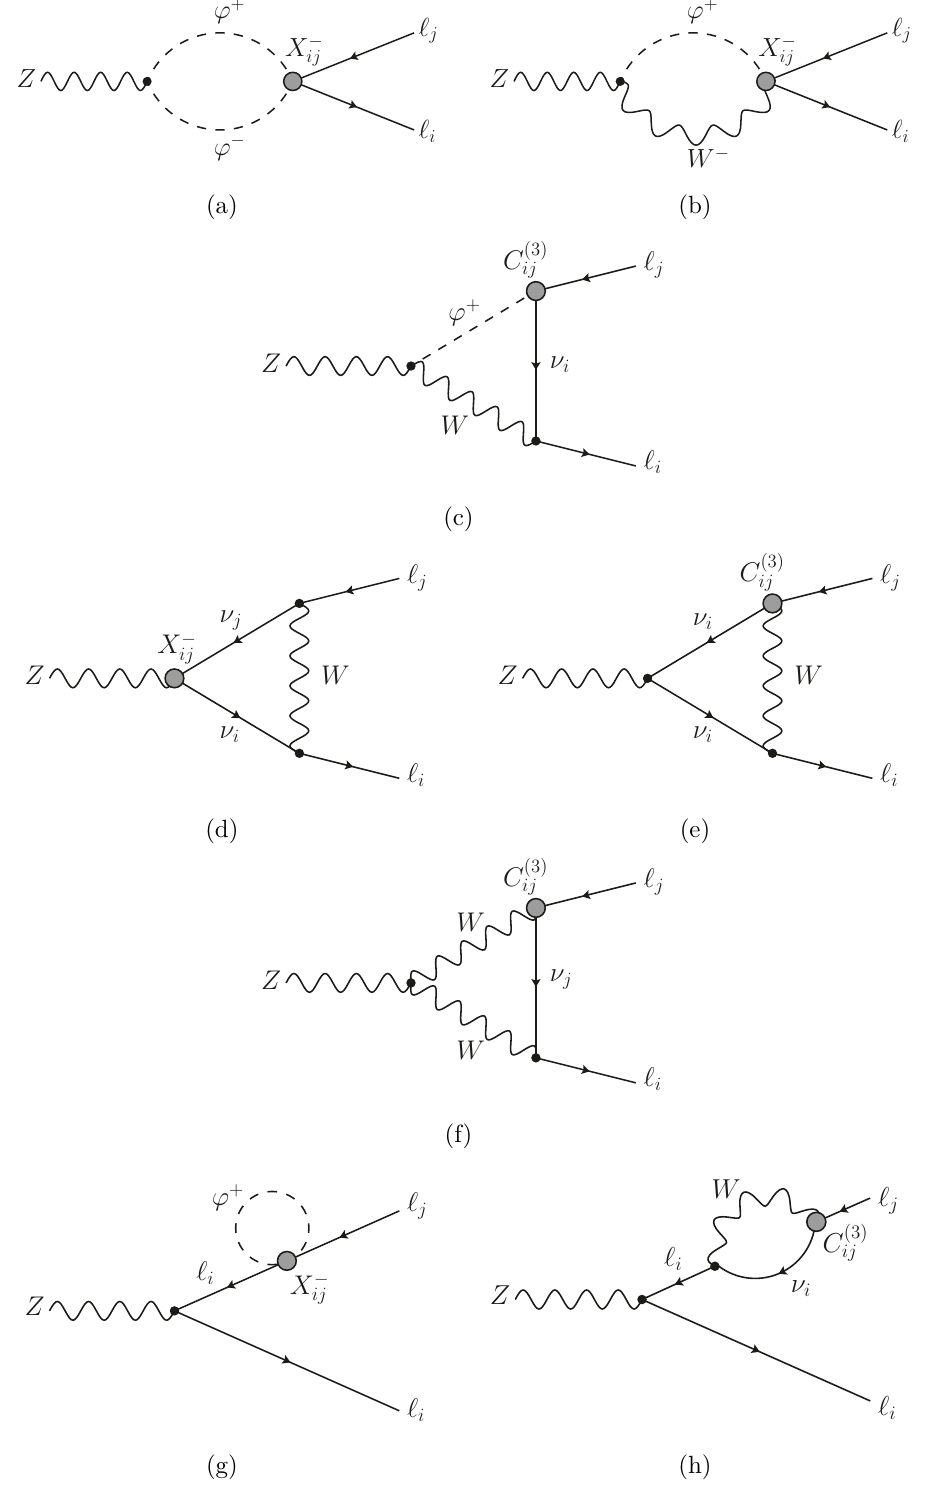
, X − and C (3) in loop diagrams contributing to the process Z → ‘‘ 0 ij ij ϕ‘,ij